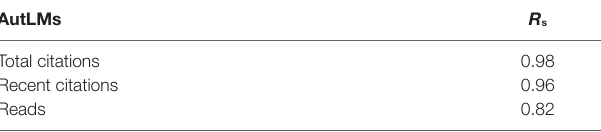
TaBle 6 | Author-level metrics (AutLMs) correlation over years